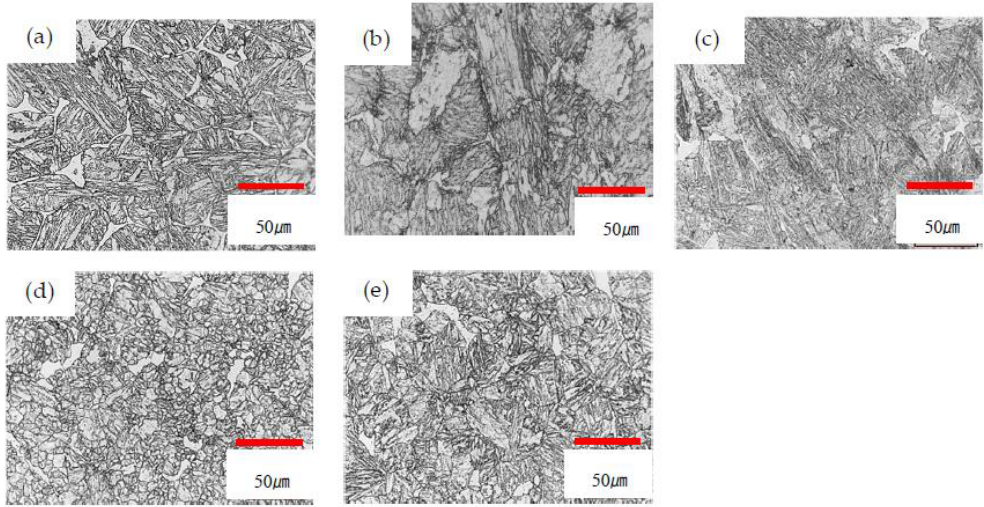
Figure 4. Optical microscope (OM) images of the alloy B steel specimens subjected to different intermediate heat treatment conditions: ( a ) as-received; ( b ) 800 °C, 6 min; ( c ) 1050 °C, 6 min and 800 °C, 6 min; ( d ) 1050 °C, 30 min, and 800 °C, 6 min; ( e ) 1150 °C, 6 min, and 800 °C, 6 min.